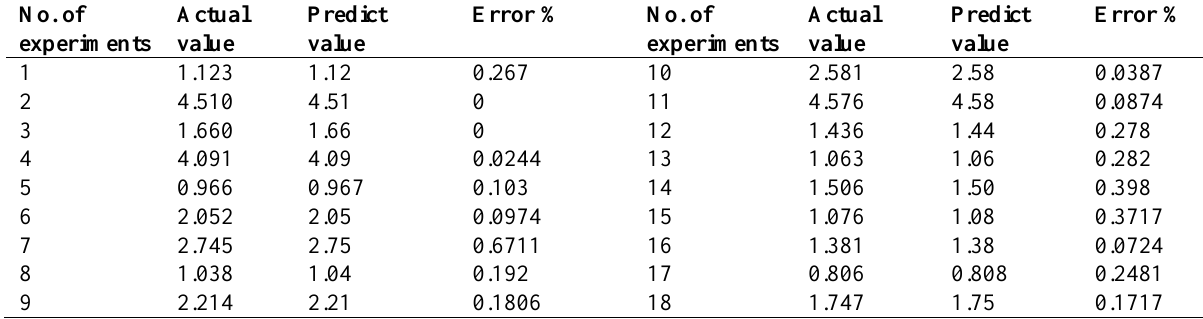
Fig. 6. Shown the membership function and epochs used for Table 4, Shown the error